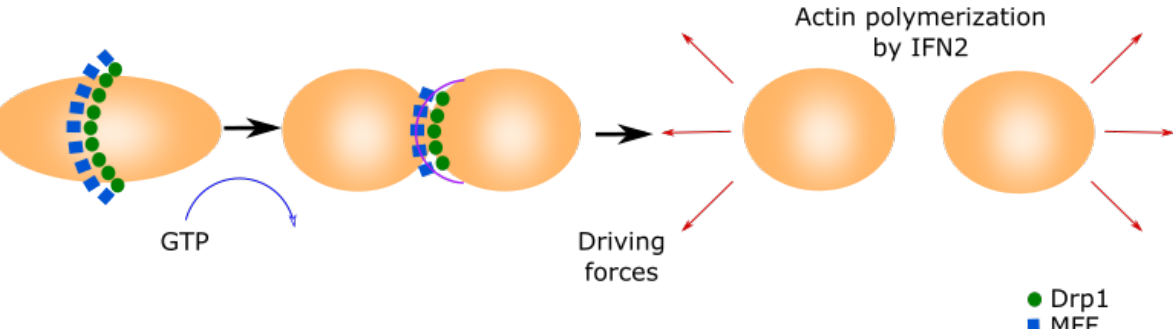
Figure 1. Mitochondrial fission.This process is initiated by MFF forming a ring in the middle of the primary organelle to be divided. Drp1 GTPase translocates to the mitochondria and binds to MFF, inducing a conformational change by the hydrolysis of GTP. This conformational change generates the ring contraction, which starts mitochondrial fission. The reorganization of the cytoskeleton generates the driving forces that separate both new mitochondria.